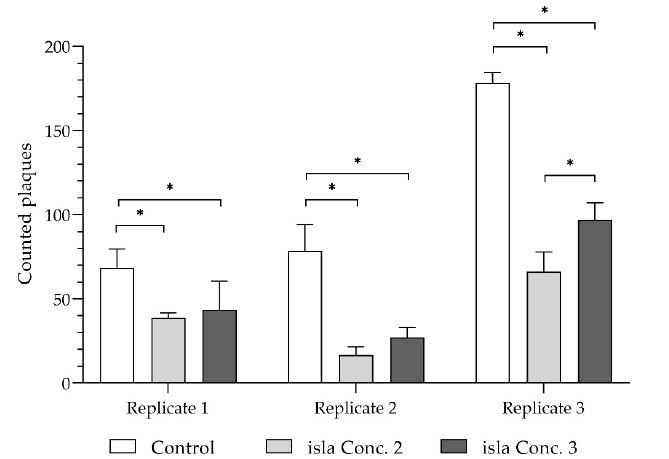
Figure 7. Results of the preventive plaque assay—Counted plaques on H1-HeLa cell monolayers of the untreated control (white) and cells treated with isla Conc. 2 (light grey) and Conc. 3 (dark grey), mean ± standard deviation of the independent test runs with three repetitions, * p ≤ 0.05.